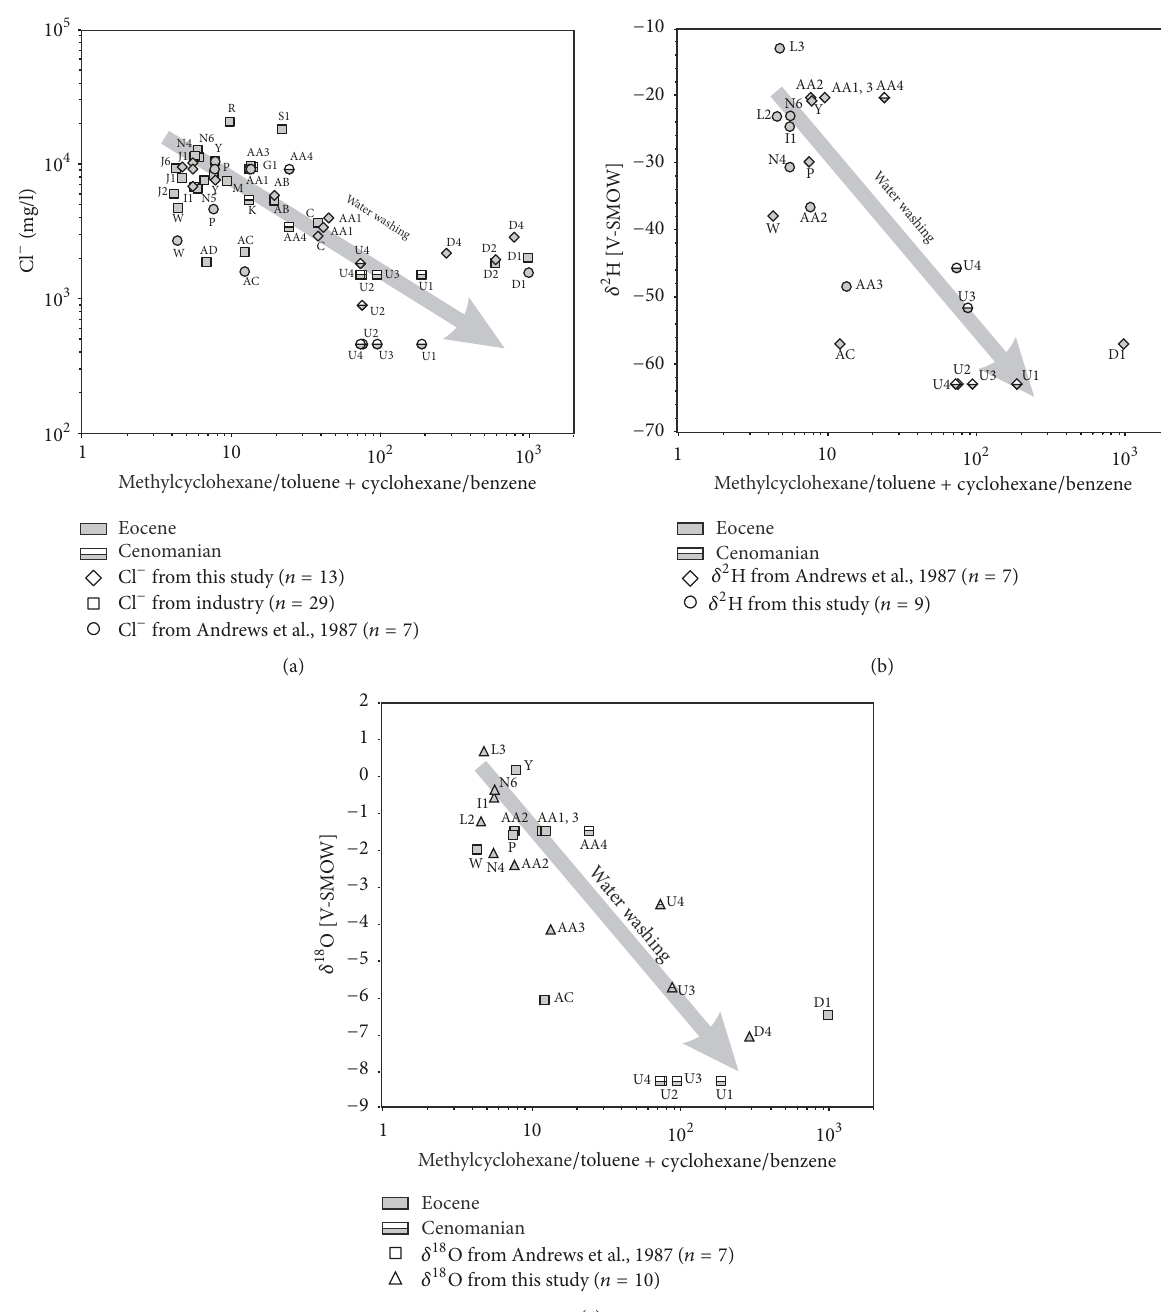
Figure 7: Cross-plots of the sum of two ratios between cycloalkanes and aromatic hydrocarbons versus (a) chlorine (Cl − ) content in reservoir waters, (b) stable hydrogen isotope ratios of reservoir waters, and (c) stable oxygen isotope ratios of reservoir waters. For sample location, see Figure